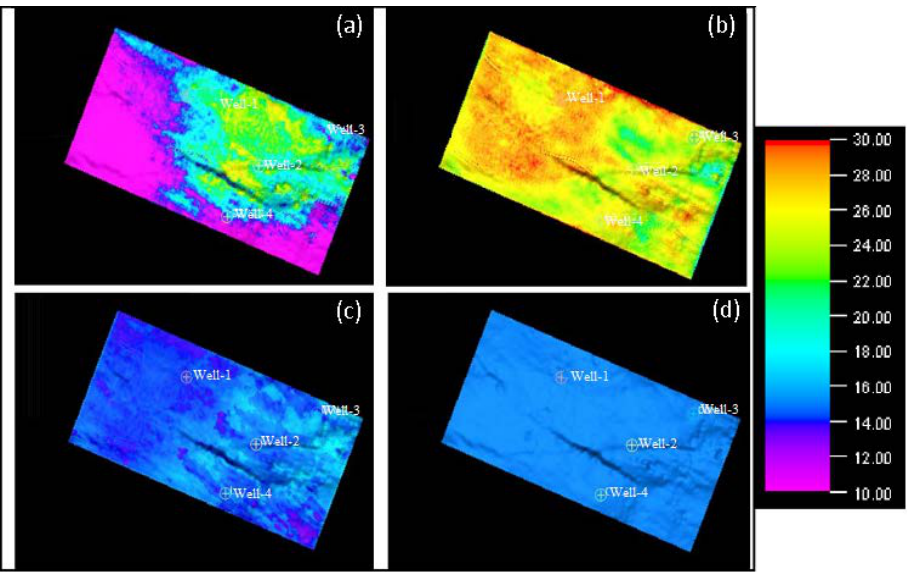
Figure 14. Second mud density cube with 90° inclination and 45° azimuth in lbm/gal for vertical well: ( a ) fracture gradient, ( b ) breakdown, ( c ) breakout, ( d ) kick.